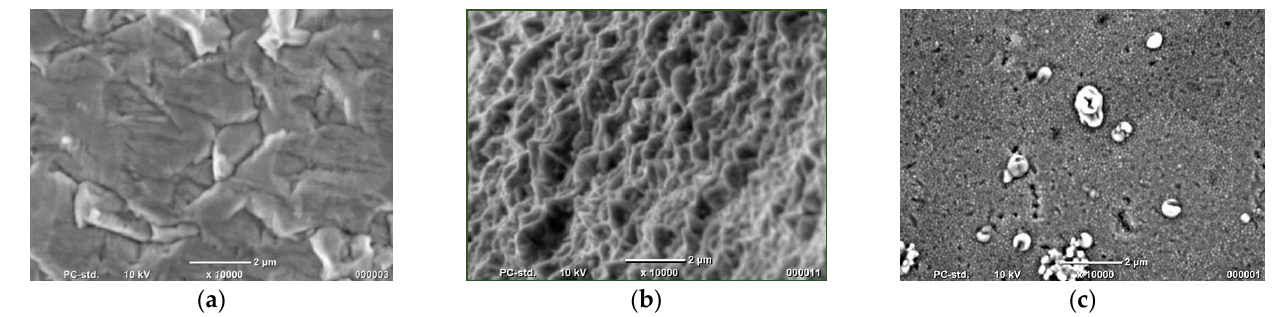
Figure 1. SEM photos of ( a ) bulk material and Co cones synthesized using ( b ) one-step method and ( c ) two-step method. Magnification: ×10,000.